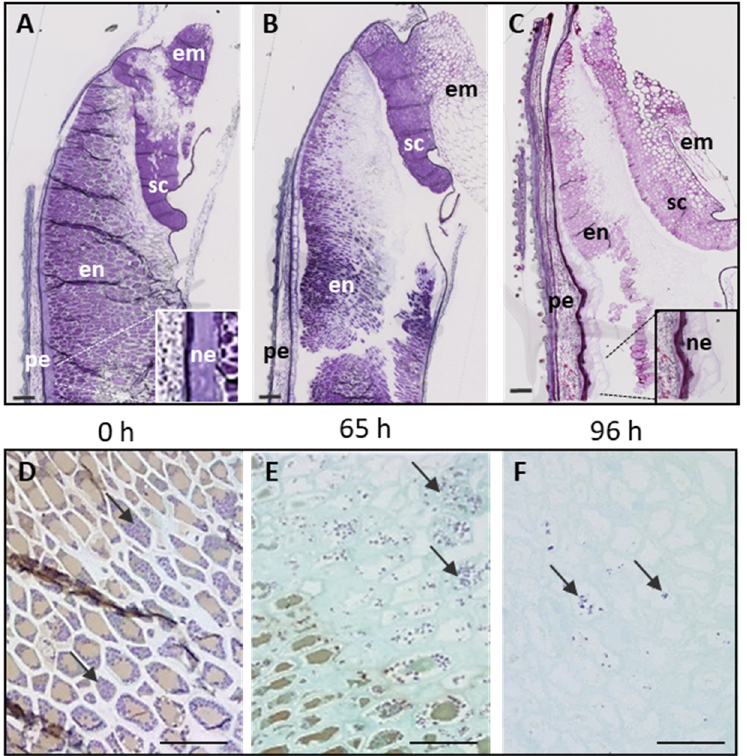
Figure 1. Histology of Brachypodium grains at 0, 65, and 96 h after the beginning of germination. Images ( A – C ): longitudinal cross-sections of grains stained with Toluidine blue. Magnifications indicate the nucellus epidermis. Images ( D – F ): endosperm cells stained with iodine and Toluidine blue. Starch granules are coloured purple by iodine while the other cellular components appear turquoise and brown with Toluidine blue. Arrows indicate starch granules. Scale bar = 100 µ m. en: endosperm; pe: pericarp; ne: nucellar epidermis; em: embryo; sc: